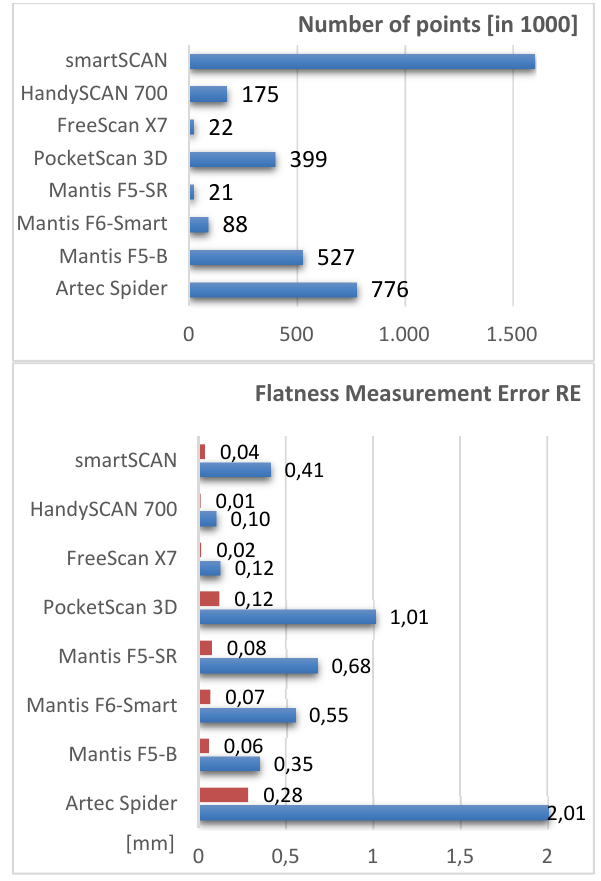
Figure 6. Quality parameter flatness measurement error (RE) equivalent to VDI/VDE 2634, part 2. Top fig.: number of points scanned, Bottom fig.: BLUE - flatness measurement error, RED - standard deviation